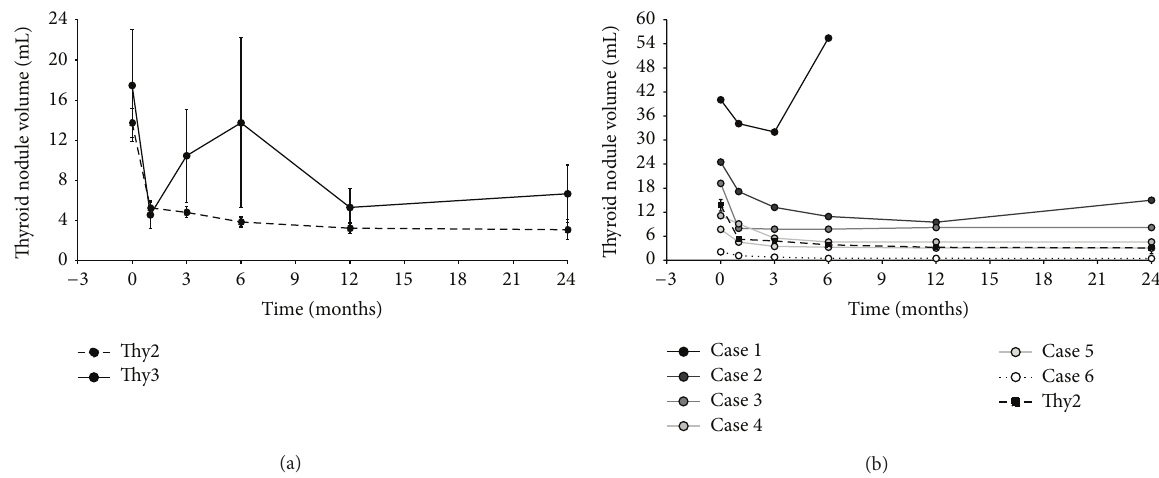
Figure 1: Volume (mL) reduction at 1, 3, 6, 12, and 24 months after RFA. (a) Dotted line represents Thy2 ( 𝑛 = 64 ) and continuous line represents Thy3 ( 𝑛 = 6 ) nodule volume reduction; (b) the volume reduction of each Thy3 nodule is represented together with Thy2 ( 𝑛 = 64 ) nodule volume